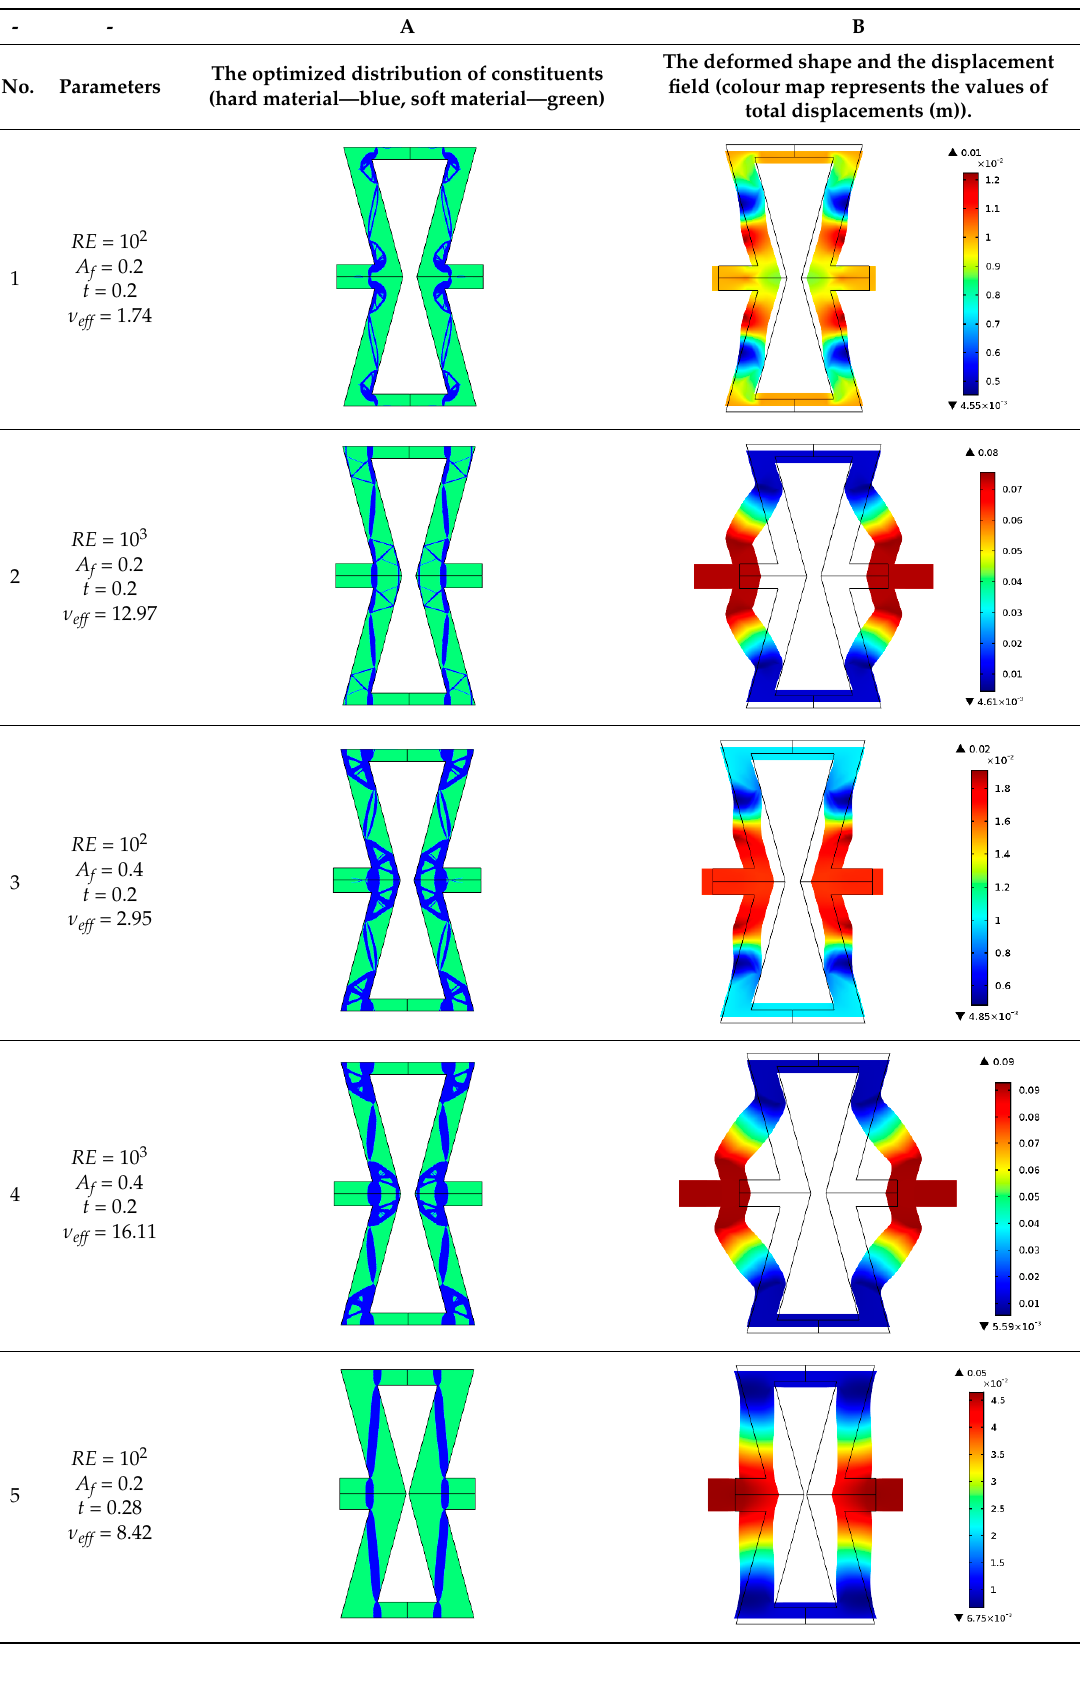
(colour map represents the values of total displacements (m)).